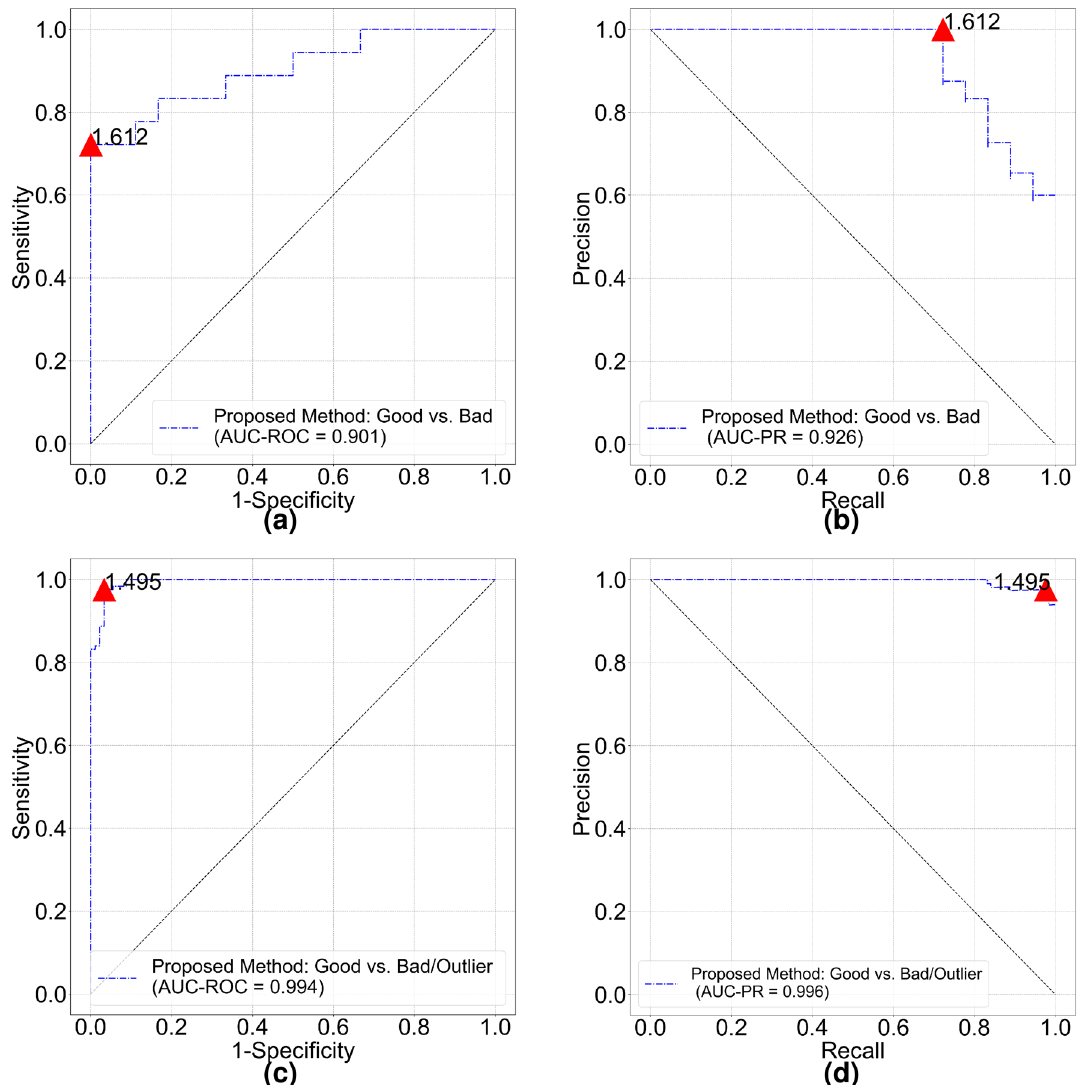
Figure 2. Classification performance of proposed vascular fractal based method. ( a ) ROC curve and ( b ) PR curve for HRF-quality database. ( c ) ROC curve and ( d ) PR curve for DRIMDB image set. Red triangle on each curve indicates optimal cut off point and the number is corresponding classification